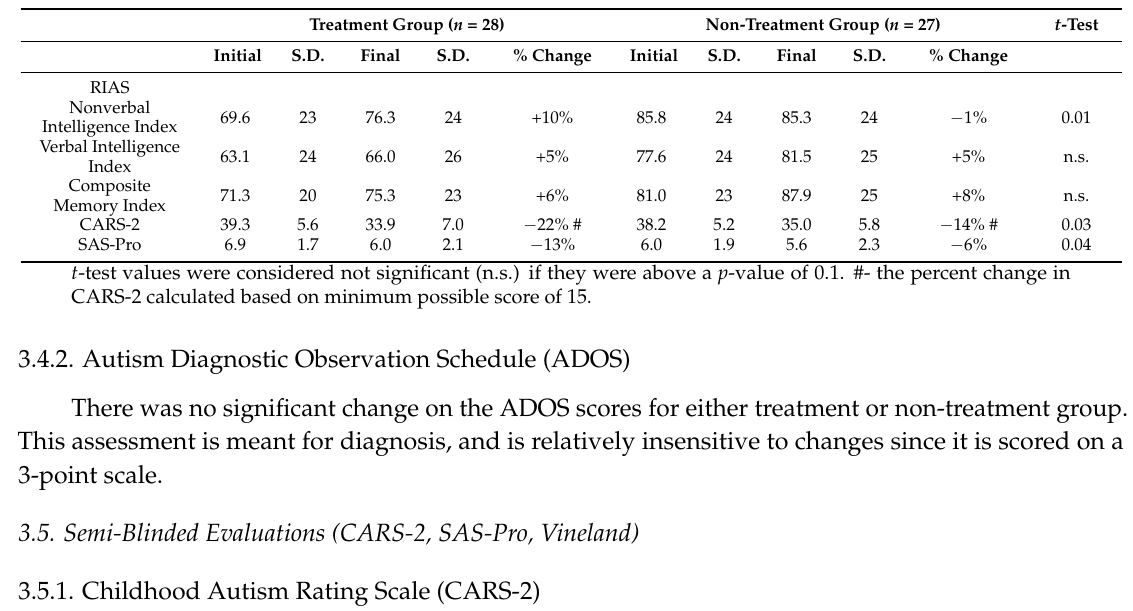
Figure 3. Reynolds Intellectual Assessment Scales (RIAS) nonverbal IQ score at the beginning and end of the study, for the treatment and non ‐ treatment groups. RIAS scores are normalized so that 100 is an “average” IQ; thus, the average of the ASD groups is substantially lower than the average for the general population. Error bars represent standard deviations. Table 4. Professional Evaluations.